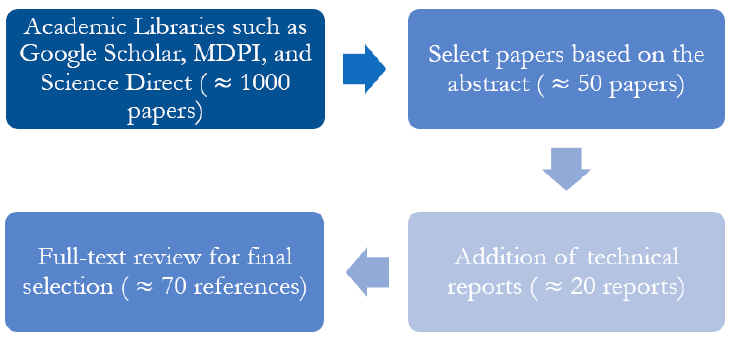
Figure 5. The selection process for papers.